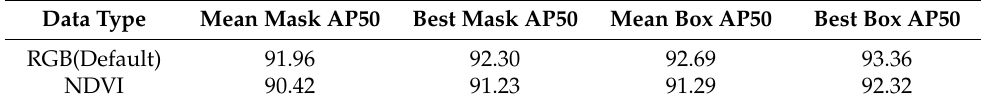
Table 7. Performances of the models for different data